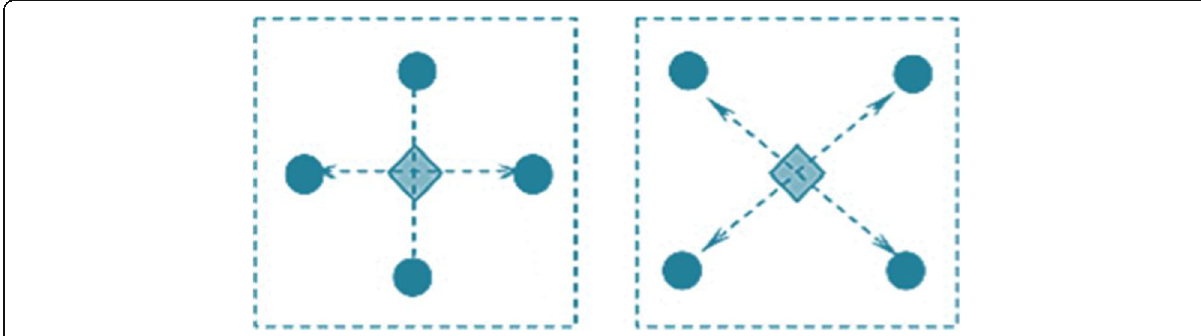
Fig. 1 General positions for underestimate pixels. There are two general positions for underestimate pixels (square symbol) which should be computed by an LMMSE-based interpolator [19]: the left part shows a position with two orthogonal directions of 0 and 90 degrees, and the right shows another position with orthogonal directions of 45 and 135 degrees